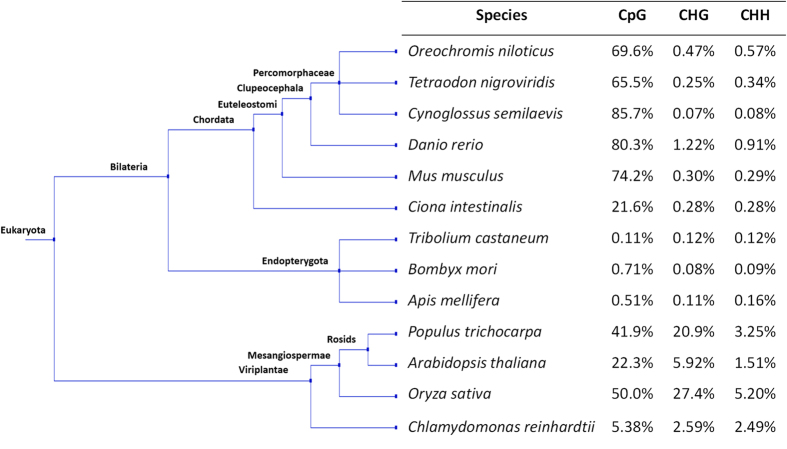
Overall methylation levels in 13 species of eukaryotes, including Oreochromis niloticus.Tree topology is generated from NCBI Taxonomy. The DNA methylation levels are from the main chromosomes of each organism, whereby chloroplast and mitochondria genomes are not included. Cytosine methylation data for T. nigroviridis, C. intestinalis, T. castaneum, B. mori, A. mellifera and O. sativa are taken from Zemach et al.34. Cytosine methylation data for D. rerio, M. musculus, P. trichocarpa, A. thaliana, C. reinhardtii are taken from Feng et al.36. Cytosine methylation data for C. semilaevis are taken from Shao et al.13.